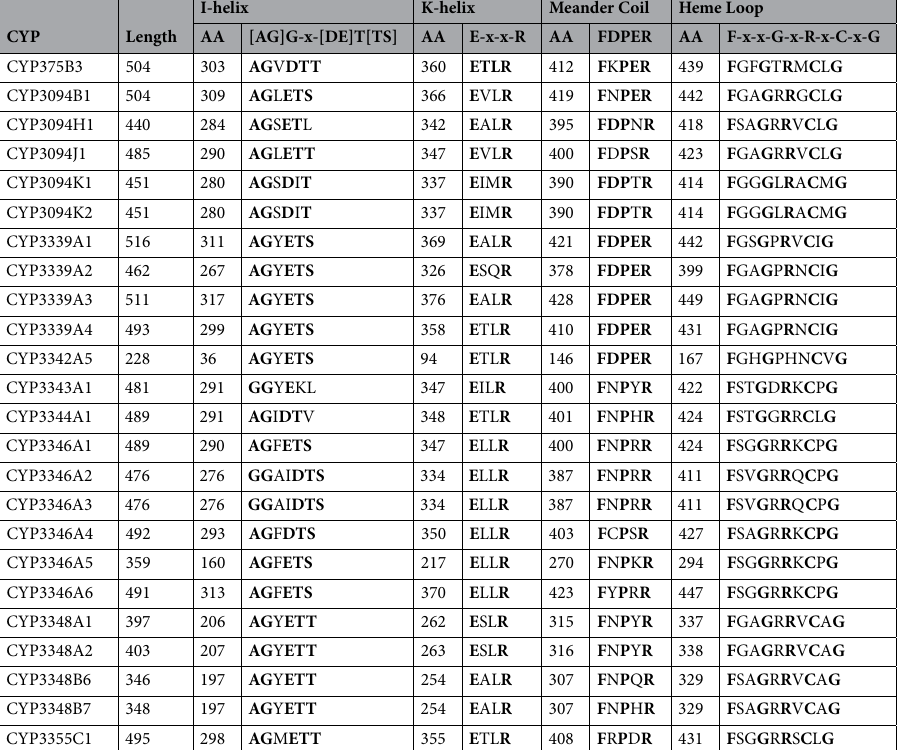
Table 2. The occurrence and position of conserved cytochrome P450 motifs in the A. digitifera CYPome. ‘Length’ indicates the total length of the translated protein sequence, and ‘AA’ is the position of the first amino acid residue for each motif. Bolded residues indicate residues that were